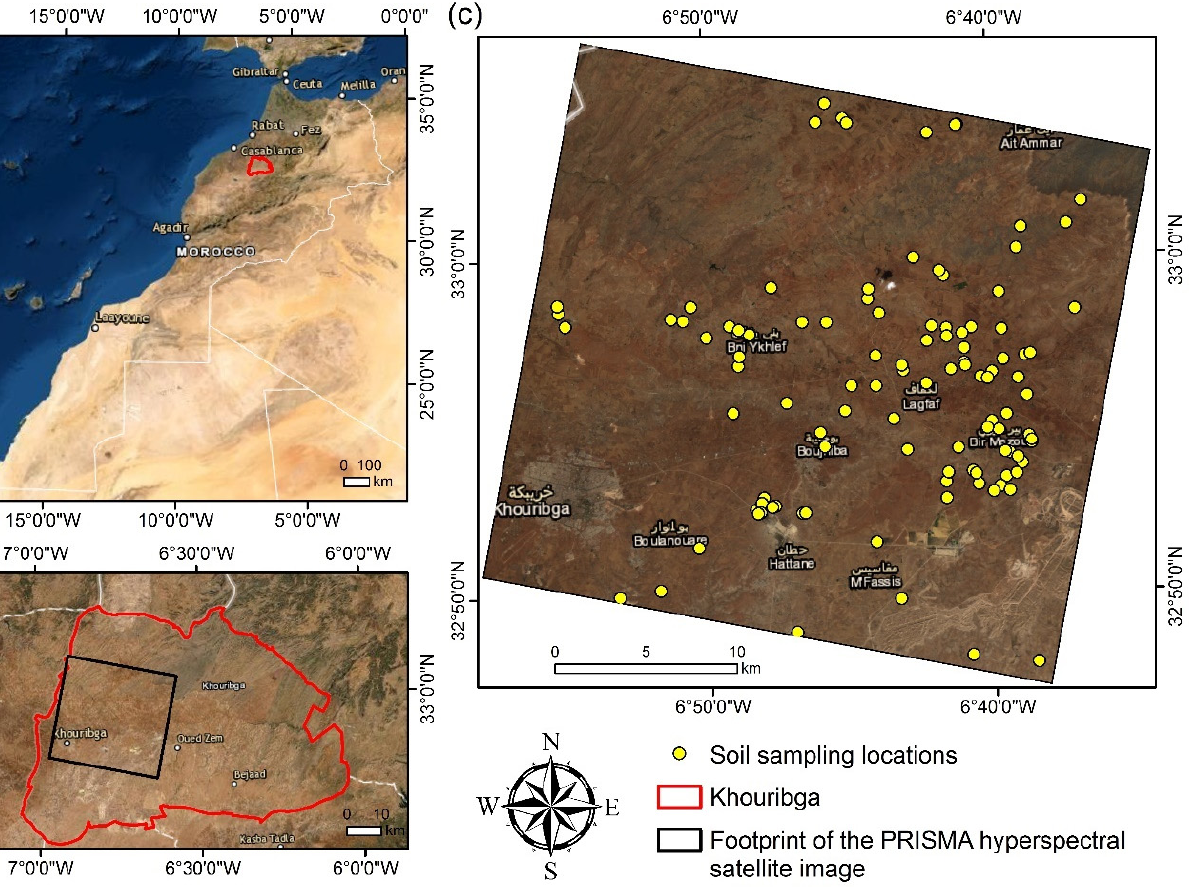
Figure 1. Location of the study area ( a ) within Morocco, ( b ) Khouribga province, and ( c ) GPS locations of soil sampling (yellow points) over the PRISMA hyperspectral image (RGB bands B34: 641.33 nm, B23: 546.48 nm, and B11: 456.37 nm).